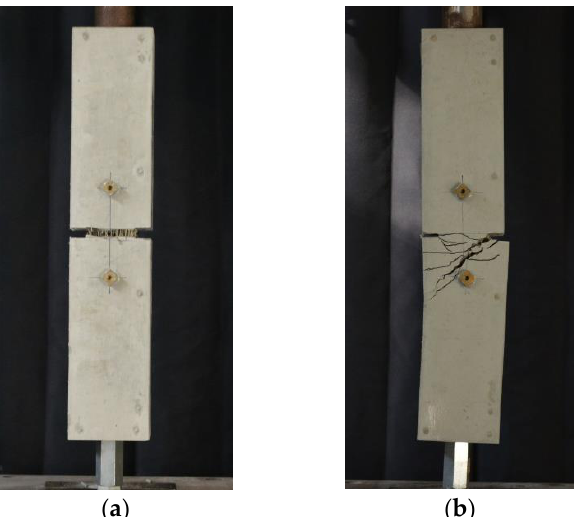
Figure 4. Failure modes of specimen in uniaxial tension test: ( a ) tensile failure; ( b ) bending failure.